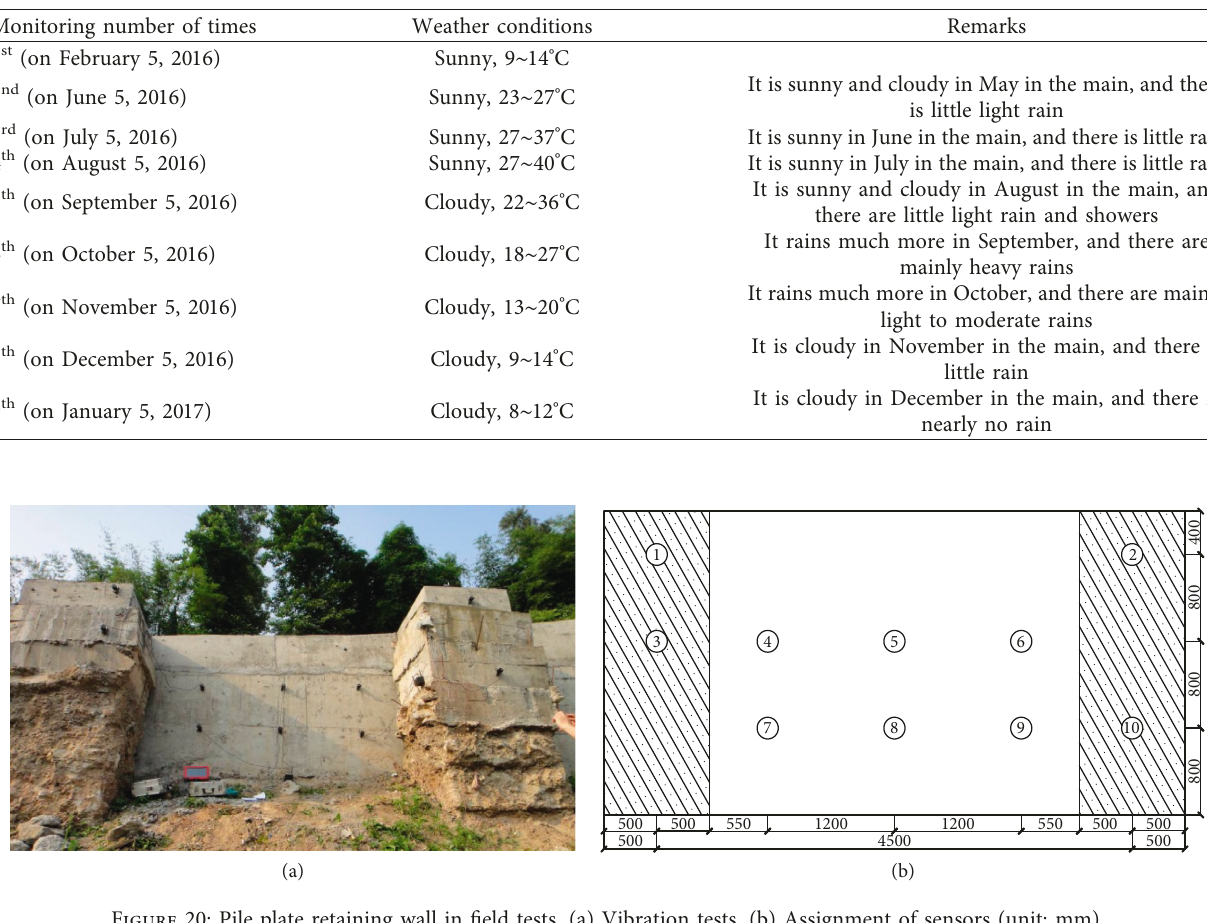
Table 5: Monitoring records in field